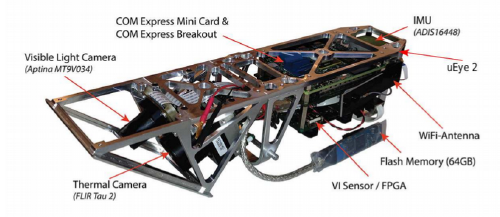
Figure 8. AtlantikSolar sensor POD.